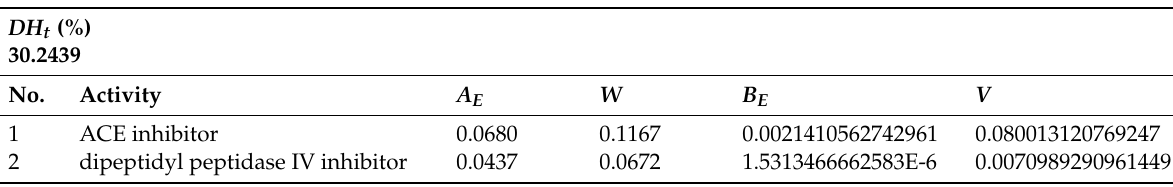
Table A52. A E , DH t , W , B E and V values from RubisCO of Halophila stipulacea . In silico enzymatic cleavage was carried out by using